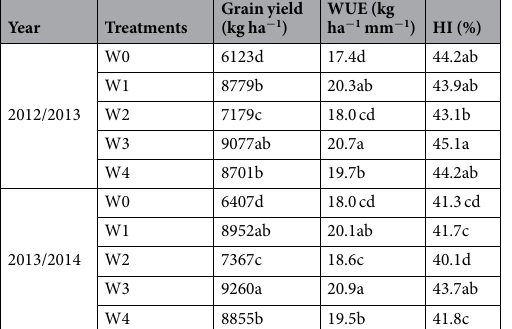
Field water holding capacity (%)